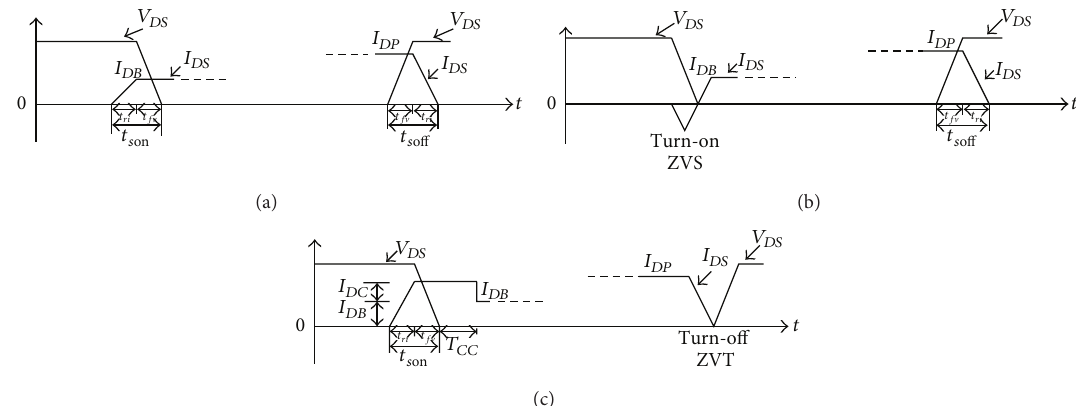
Figure 11: Conceptual current and voltage waveforms of switch in the interleaved boost converter (a) with hard-switching circuit, (b) with boost type snubber, and (c) with single-capacitor snubber.